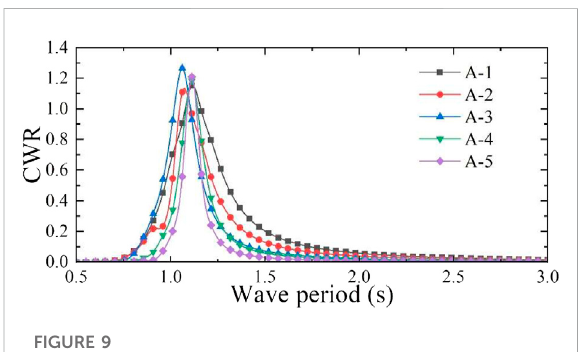
FIGURE 9 CWR of fi ve models with different dual-chamber geometry sizes.